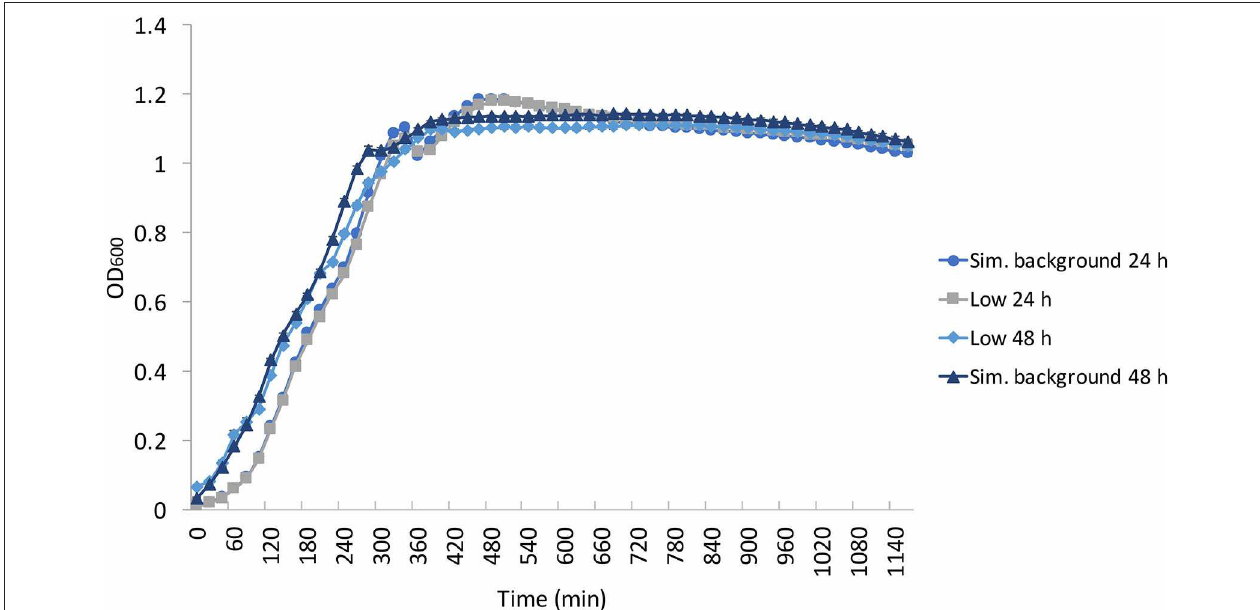
FIGURE 4 | Average ( n = 84) of E. coli growth curves at the determined low radiation (“low”) and artificial background radiation (“sim. background”) dose rate: 24 and 48h denote time in hours that bacteria batch has spent in respective conditions. Error bars show ± standard error ( n = 84).